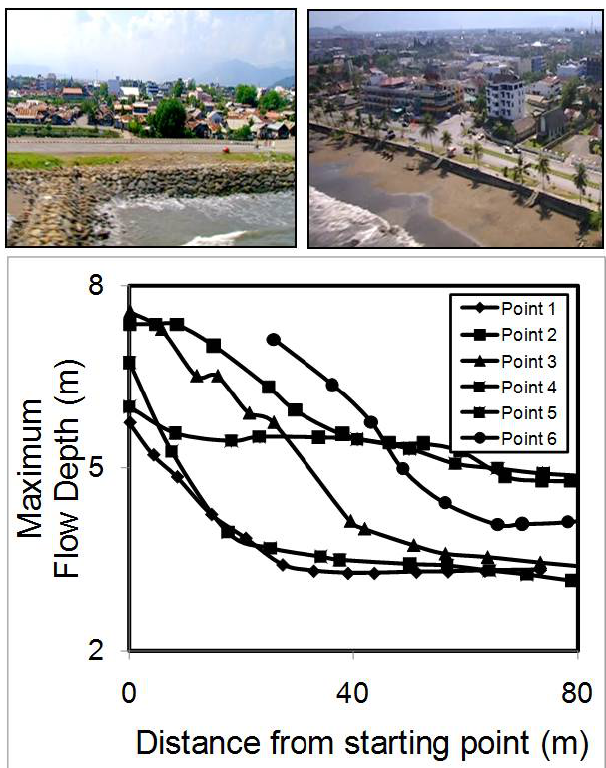
Fig. 14. Small seawalls and groins along the coast of Padang city (top figures), and the reduction of tsunami flow depth because of their existence (bottom